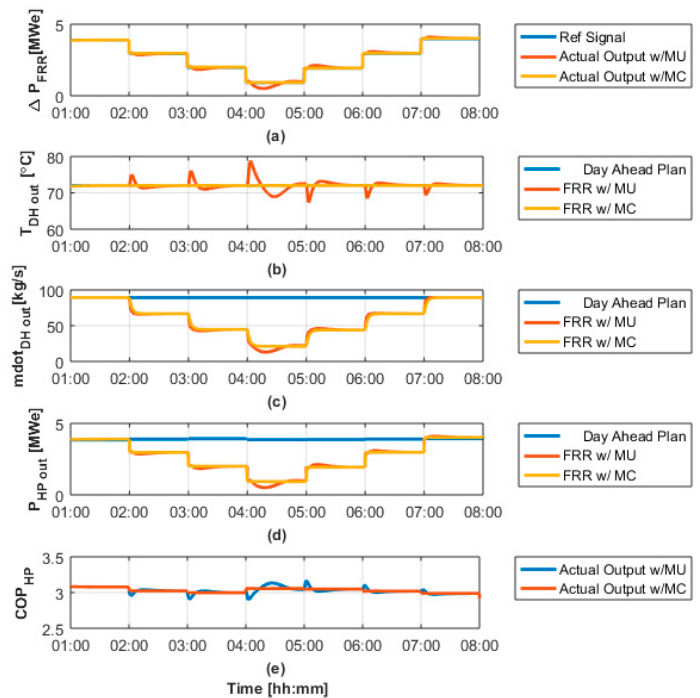
Figure 14. Heat-Pump response to a synthetic mFRR activation signal from TSO control center: ( a ) additional power contribution according to FRR response; ( b ) temperature of forwarded water into DH network; ( c ) hot water’s mass-flow to DH network; ( d ) electrical power consumption of HP and ( e ) HP’s COP.